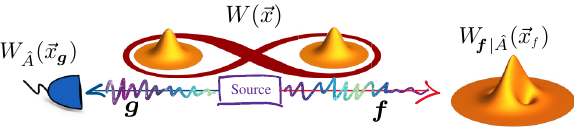
FIG. 3. Sketch representation of the conditional preparation scheme for creating the non-Gaussian states described by Eq. (190). Note that both f and g can be highly multimode. The Wigner function shown on the right is obtained by a conditional protocol shown in Ref.